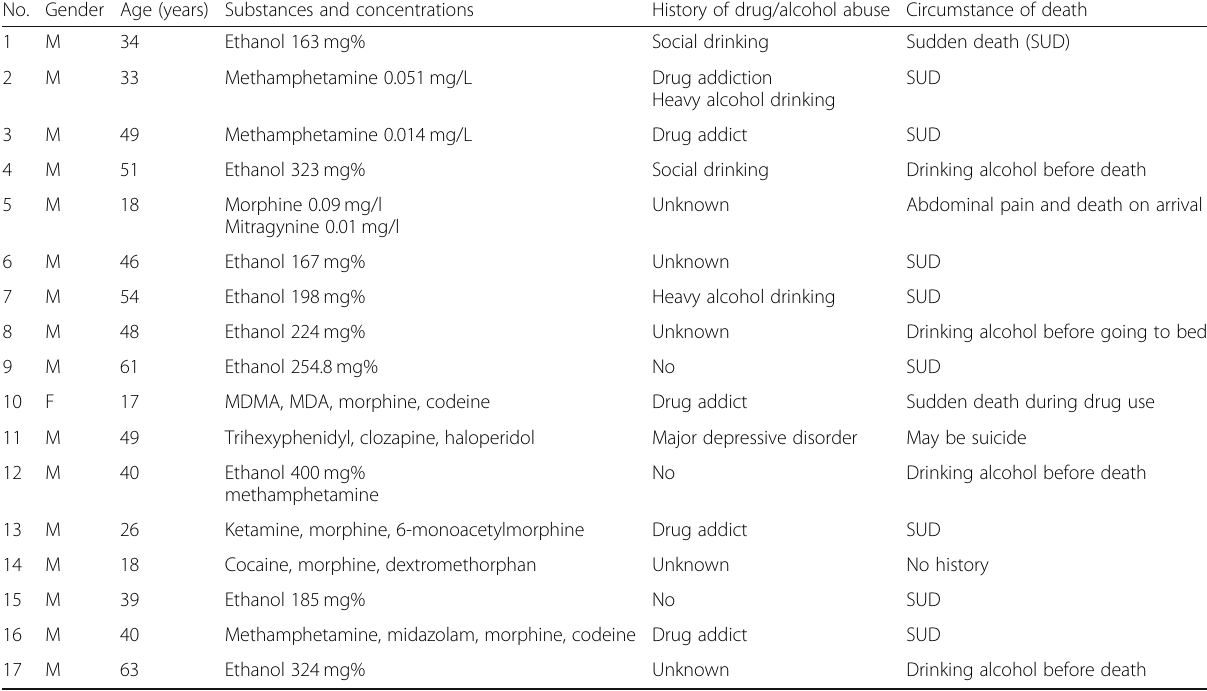
Table 7 The data of each myoglobin positive case in the study group No. Gender Age (years) Substances and concentrations History of drug/alcohol abuse Circumstance of